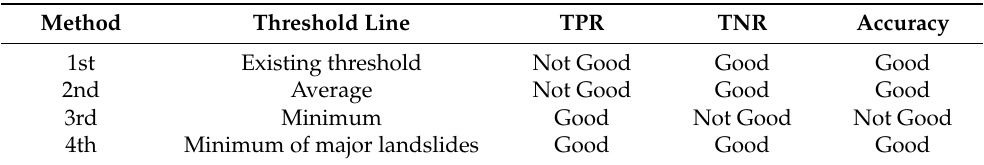
Table 5. The general performance of the